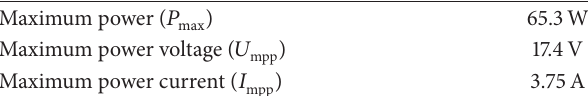
Table 2: Data sheet of KC65T at 1000 W/m 2 , 25 ∘ C.